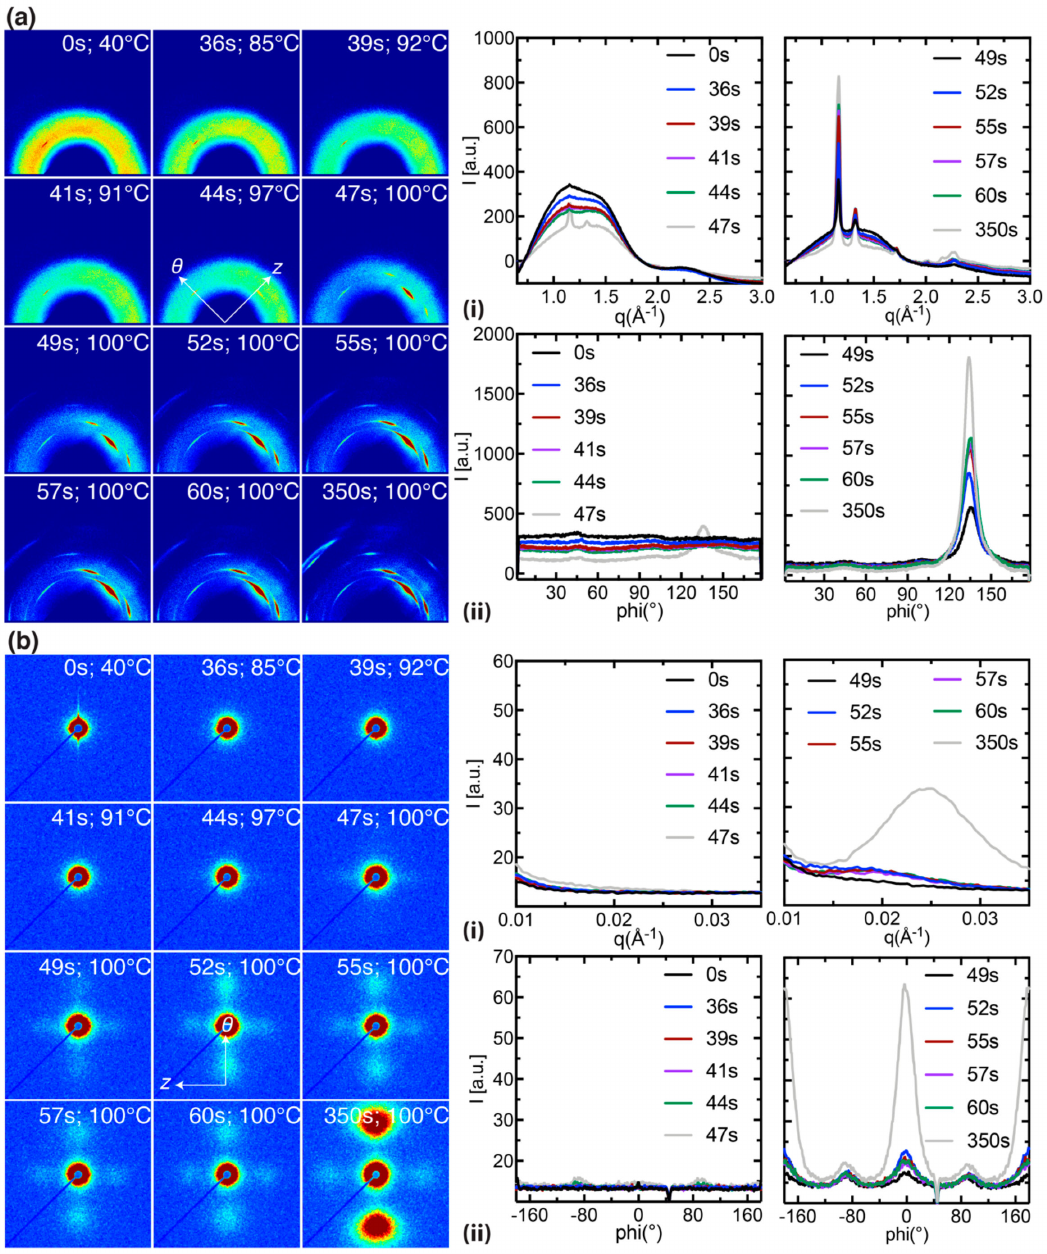
Figure 6. In situ ( a ) WAXS and ( b ) SAXS data acquired on a PLLA preform stretched at T x mold = 100 ◦ C. The diffraction patterns capture the transient heating and annealing steps (t < 350 s, T a mold = 100 ◦ C) and correspond to the temperature and strain profiles in Figures 3 and 4b. Diffraction patterns acquired during the cooling step (t > 350 s) can be found in Figure S20. The WAXS and SAXS data are presented as: 2D patterns; ( a , b , i ) azimuthally averaged intensity I( q ); and ( a , b , ii ) radially averaged intensity I( ϕ